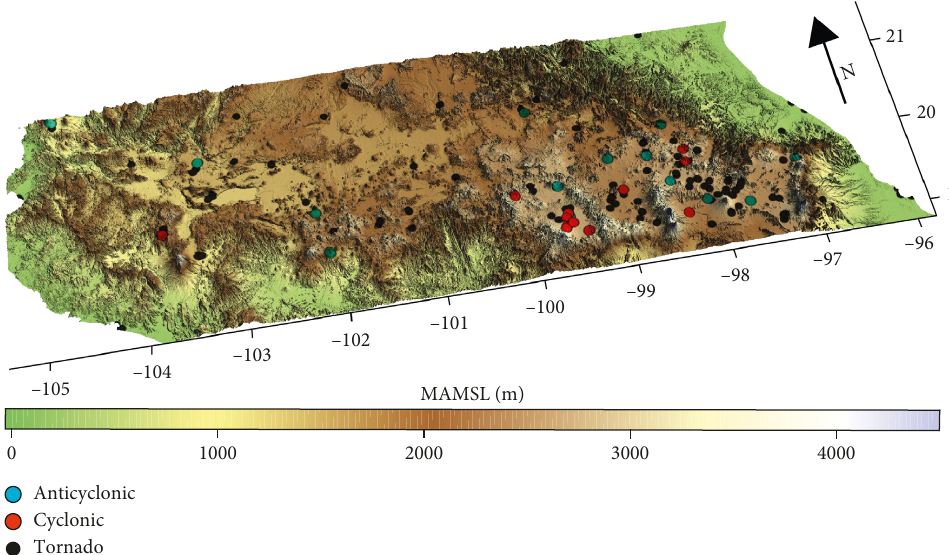
Figure 4: Tornado positions in the complex orography of the TMVB. Blue (anticyclonic) and red (cyclonic) points indicate the position of the documented tornadoes where the sense of rotation was determined.